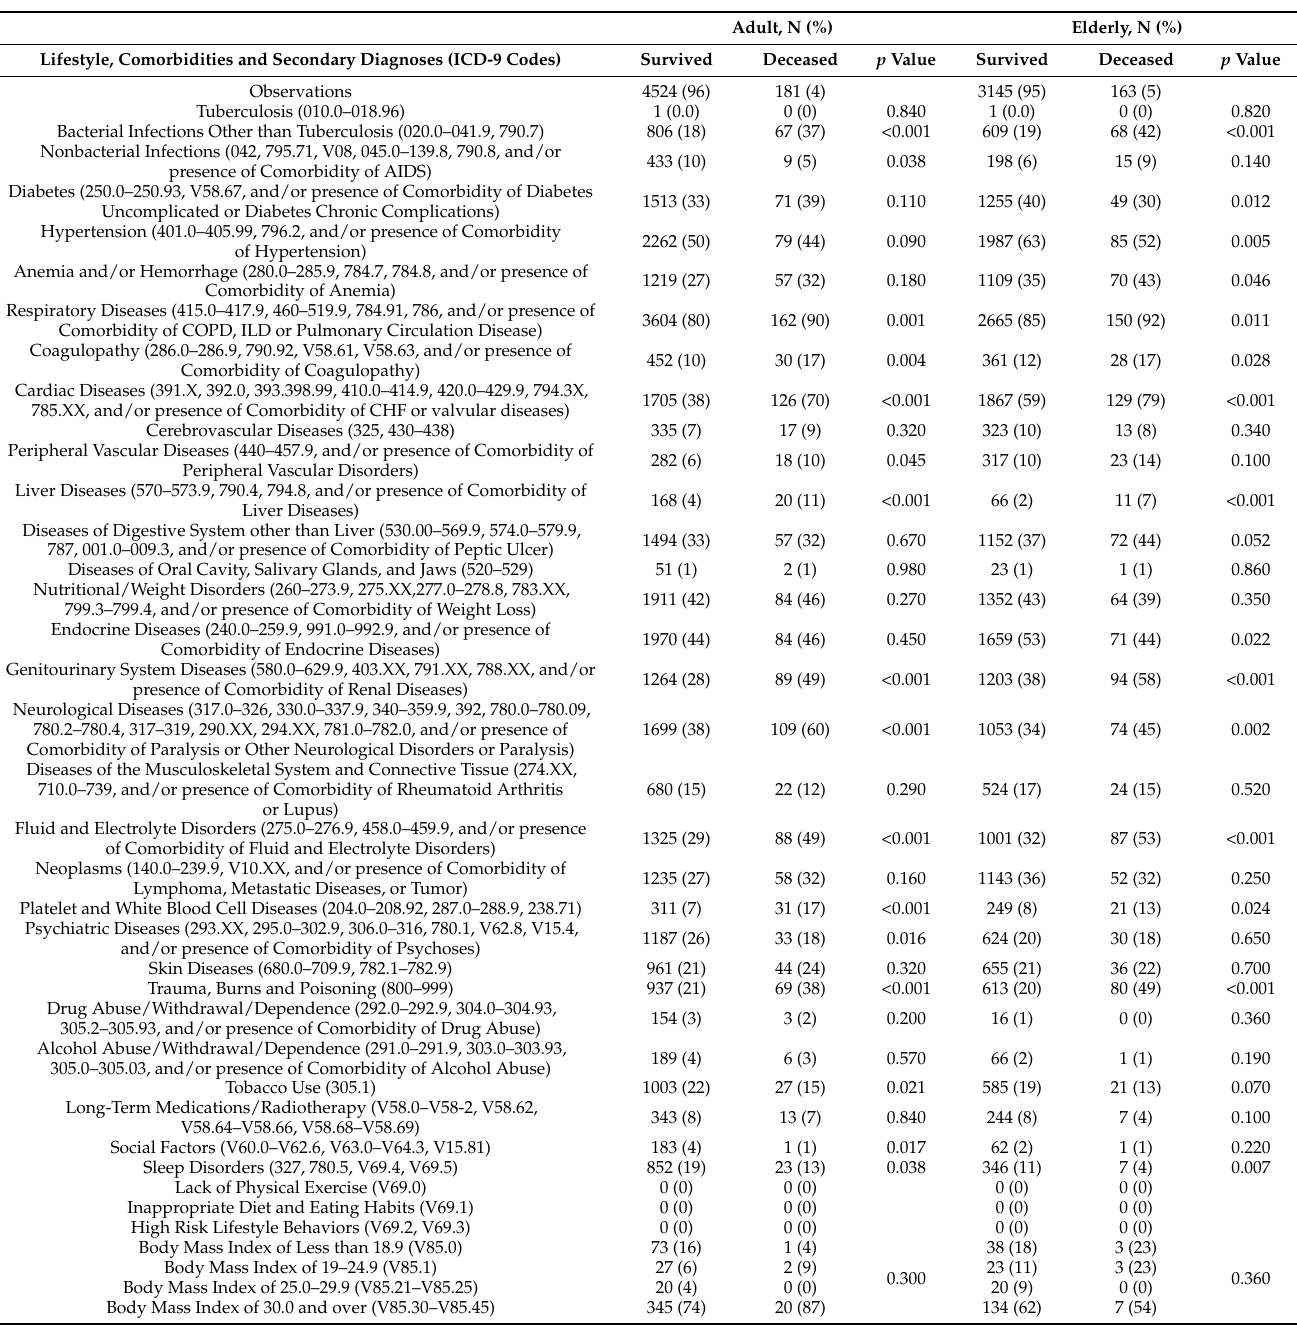
Table 6. Lifestyle, comorbidities, and secondary diagnoses of patients emergently admitted with a primary diagnosis of tracheostomy complications (NIS 2005–2014). Data were stratified according to survival